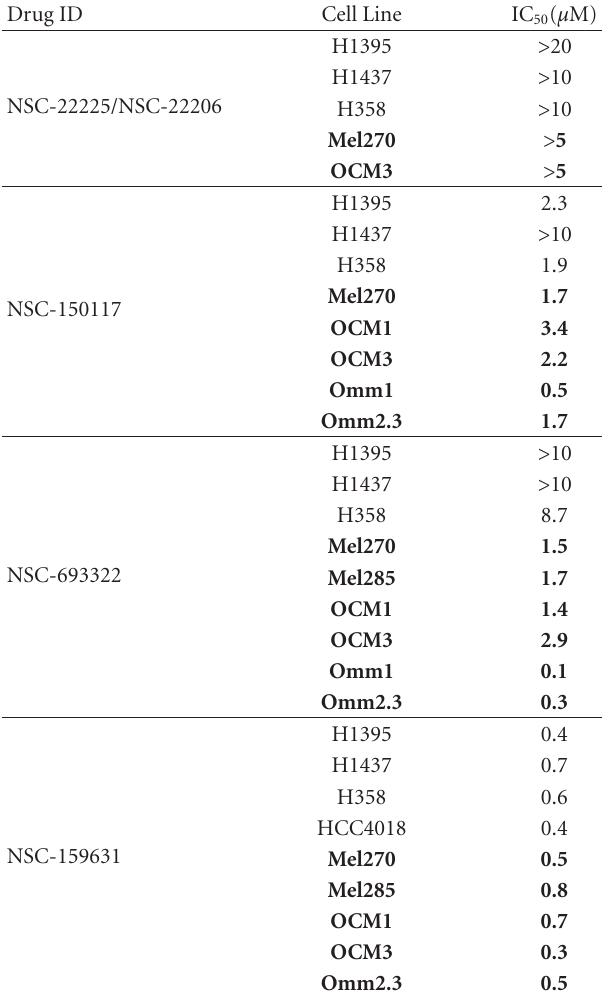
Table 2: Characterization of the anticancer properties of hits. Cell viability assays were performed with hits from the assay, and IC 50 values were obtained for several nonsmall cell lung cancer cell lines and several melanoma cell lines